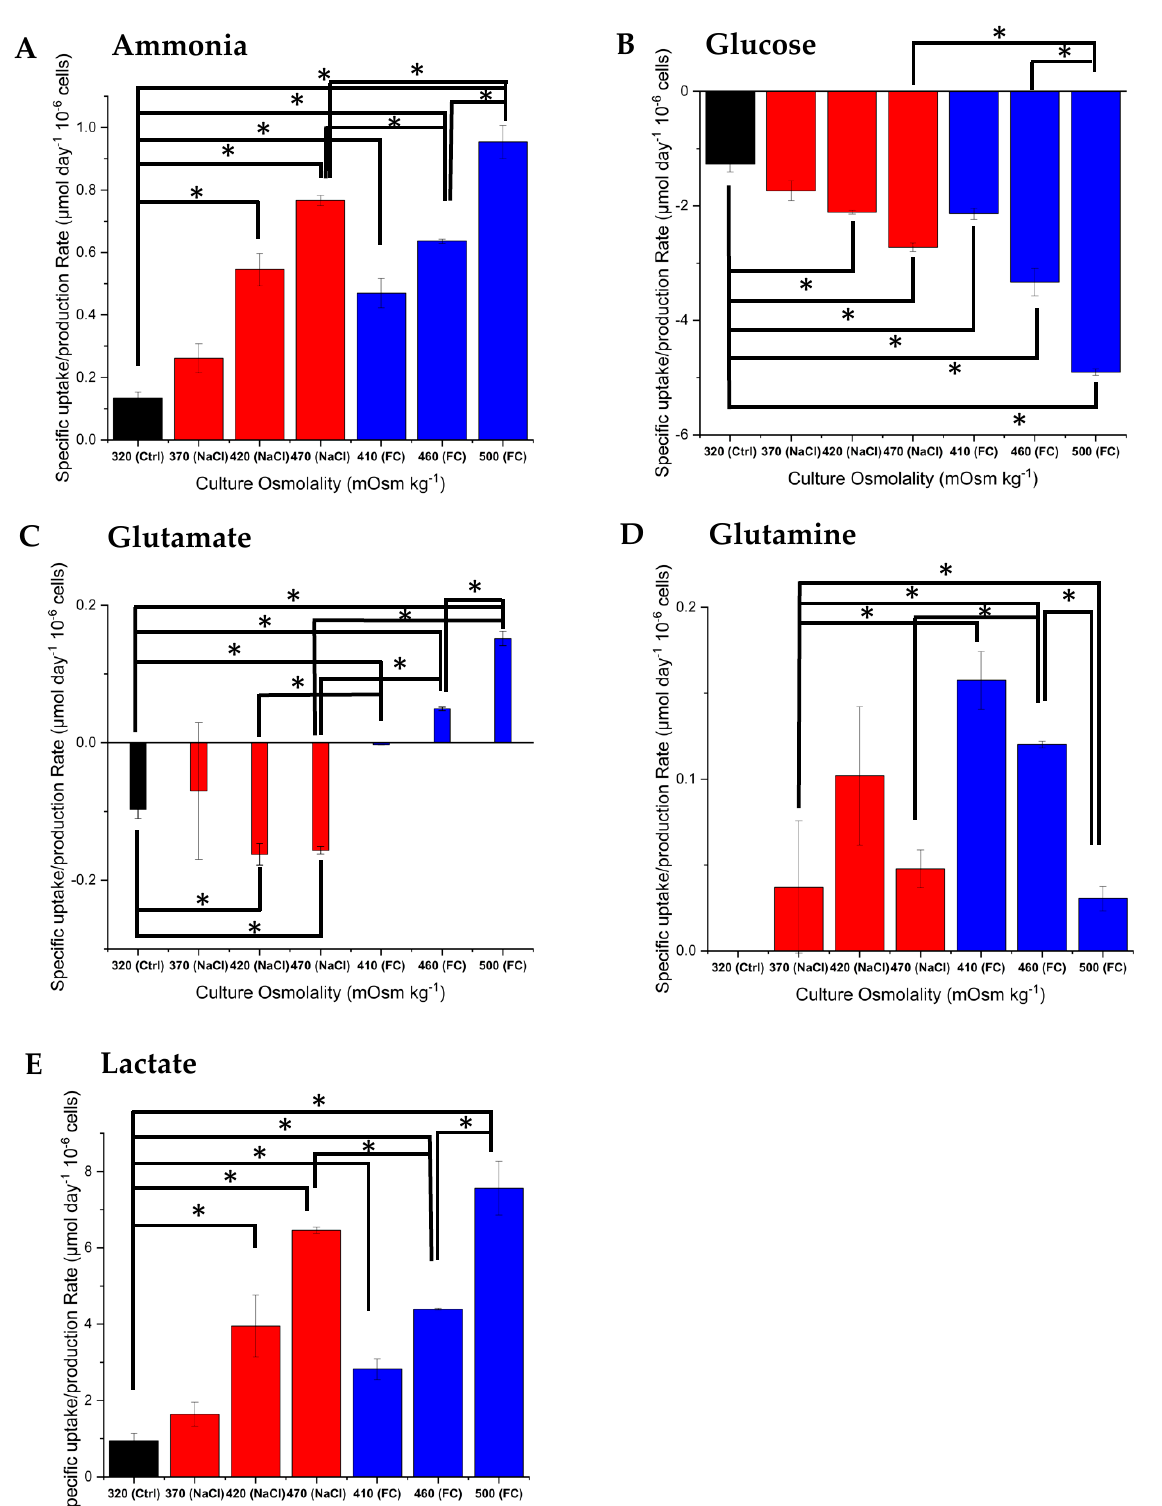
Figure 3. Specific uptake/production rates of ( A ) ammonia, ( B ) glucose, ( C ) glutamate, ( D ) glutamine and ( E ) lactate under different osmolality conditions. The control cultures produced no detectable levels of glutamine. Error bars represent the standard deviation of two biological replicates. For the analysis of significance (* p < 0.05), equal variance of each variable between different experiments was